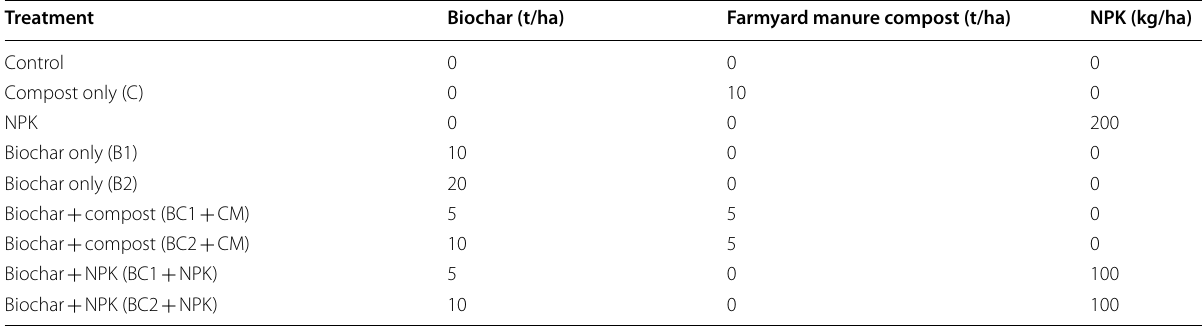
Table 2 Treatment rate of biochar, farmyard manure compost and NPK used in the previous experiment Treatment